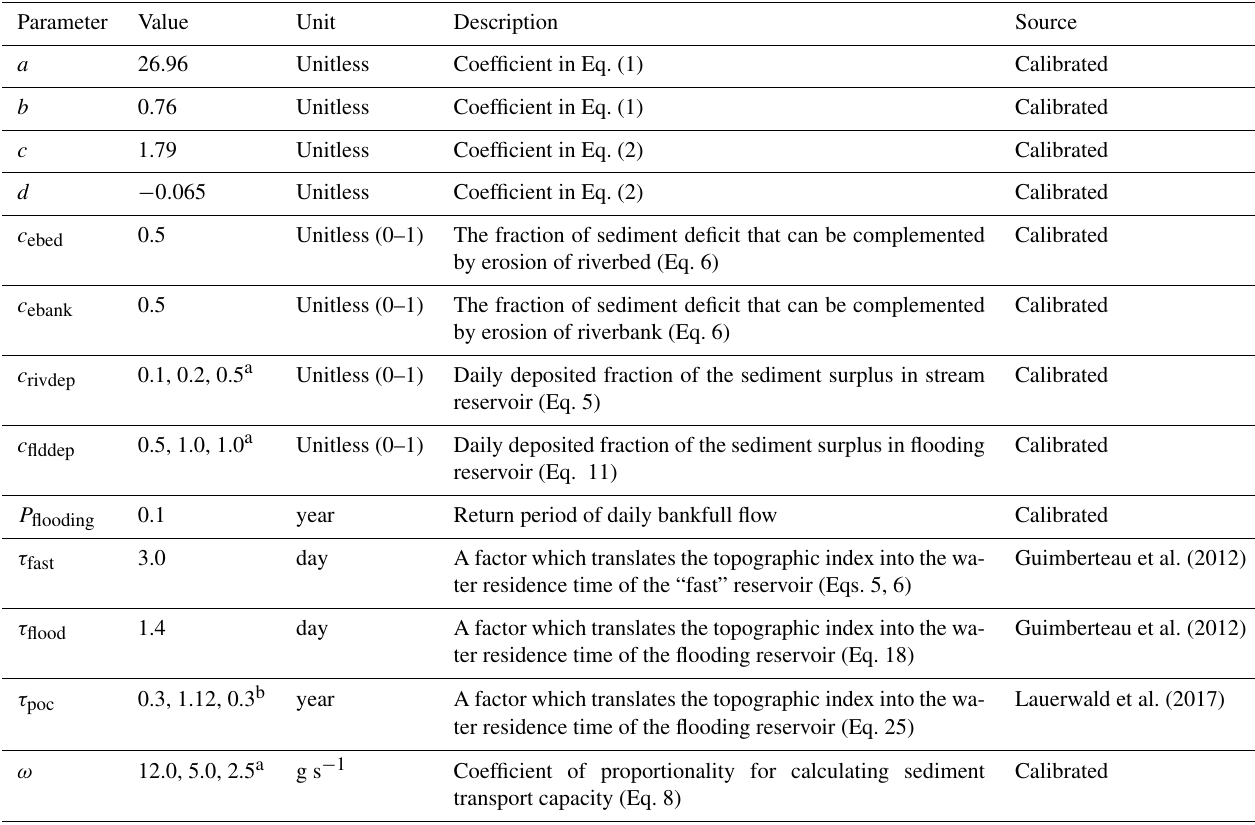
Table 2. Values of the key parameters used in ORCHIDEE-C lateral to simulate the lateral transfer of sediment and